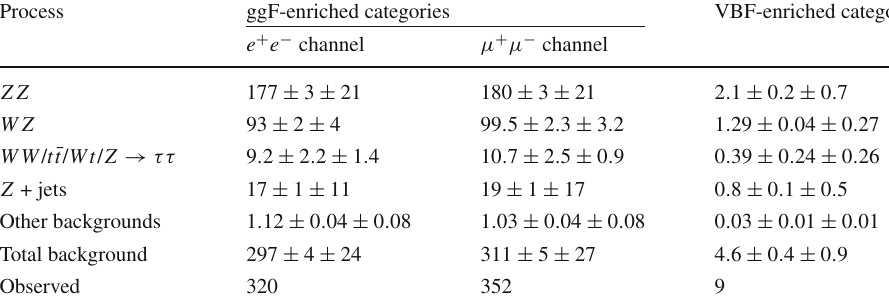
Table 5 (cid:3) + (cid:3) − ν ¯ ν search: expected and observed number of events together with their statistical and systematic uncertainties, for the ggF- and VBF-enriched